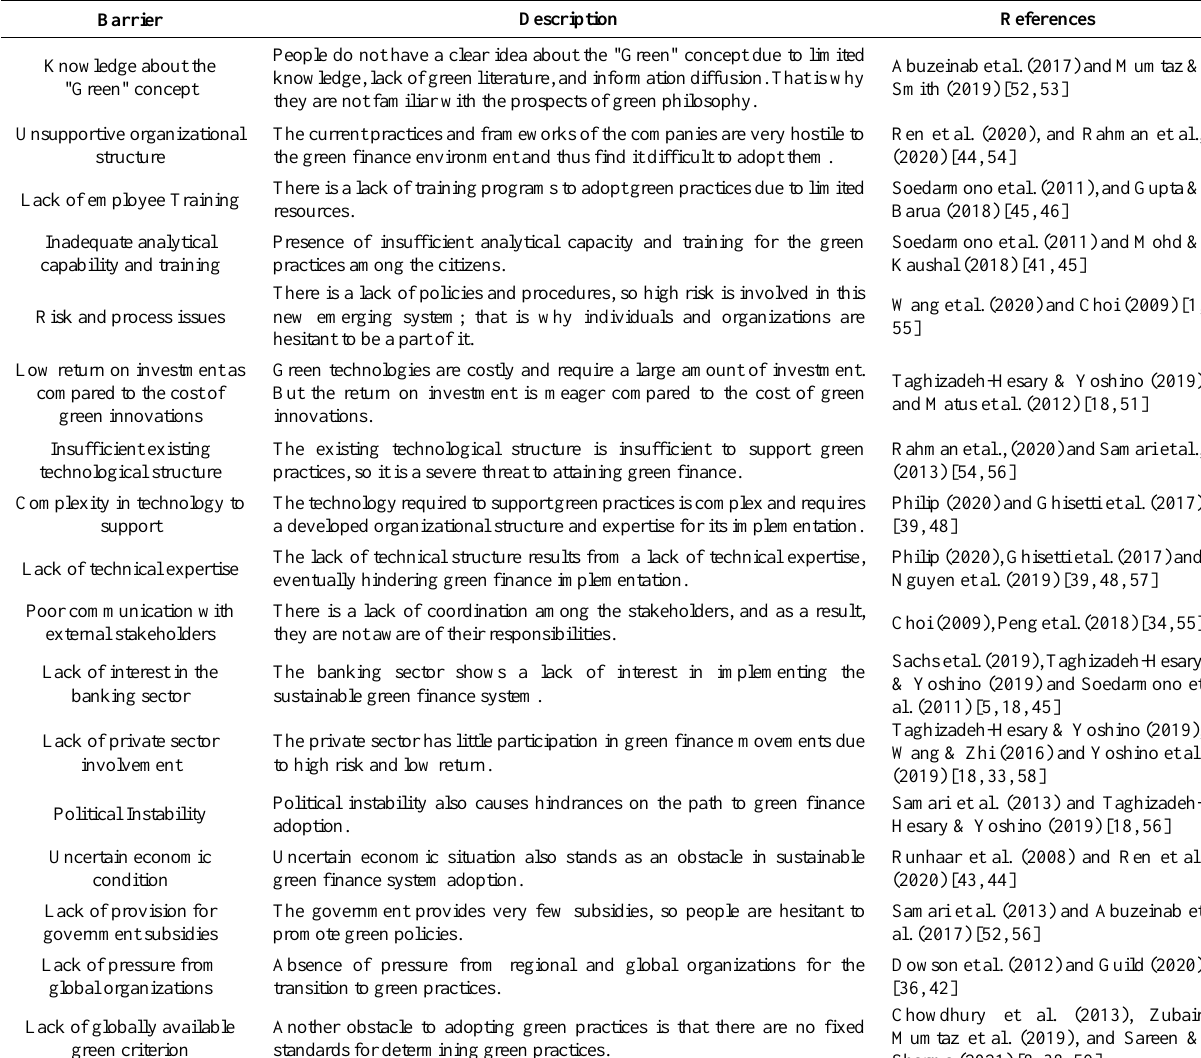
Table 2. List of barriers to green finance